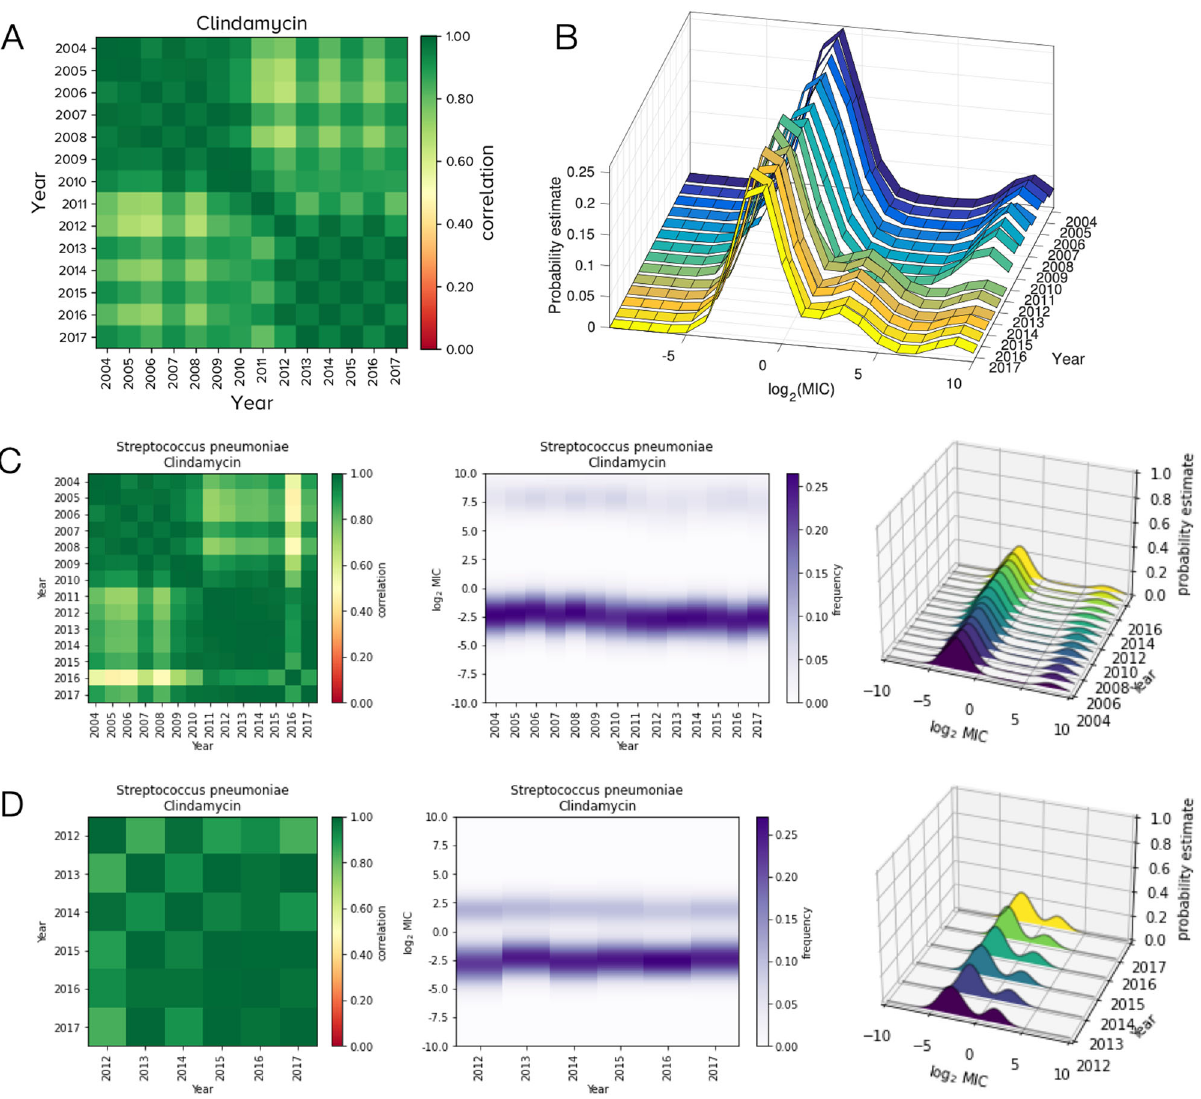
Fig. 4 Evidence S. pneumoniae and clindamycin MIC dynamics are the result of database curation methodologies. Show an analogous structural shift to Fig. 1B, C for S. pneumoniae and erythromycin: the correlelogram (in A ) and MIC dynamics (in B ) shift towards lower MICs around 2011. The result of separating ATLAS into its ( C )) TEST and ( D )) INFORM components are then shown. These indicate the loss of the most-resistant cluster from B around 2011 is due to TEST and INFORM both having bimodal MIC distributions with different high-MIC clusters (see C(right) and D(right)). When both the latter are amalgamated to form ATLAS, noting ( D ) has data only after 2012, this appears (in ( B )) to change the structure and dynamics of the MIC distributions when, in fact, these are artefacts re fl ecting the merging of 2